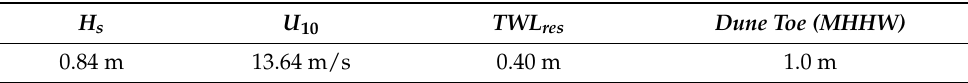
Table 2. The 95th percentile values used as the exceedance thresholds to determine coastal hazard event occurrences from 2015 to 2019 and the morphological exceedance